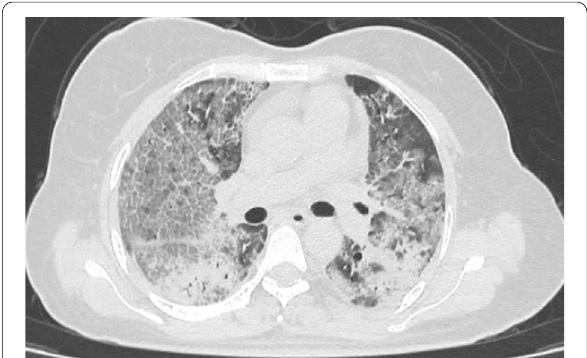
Fig. 4 Axial CT image indicating severe disease severity with ARDS pattern (CTSS 25). Axial CT image shows diffuse extensive bilateral GGOs with crazy paving and multifocal consolidation bilaterally